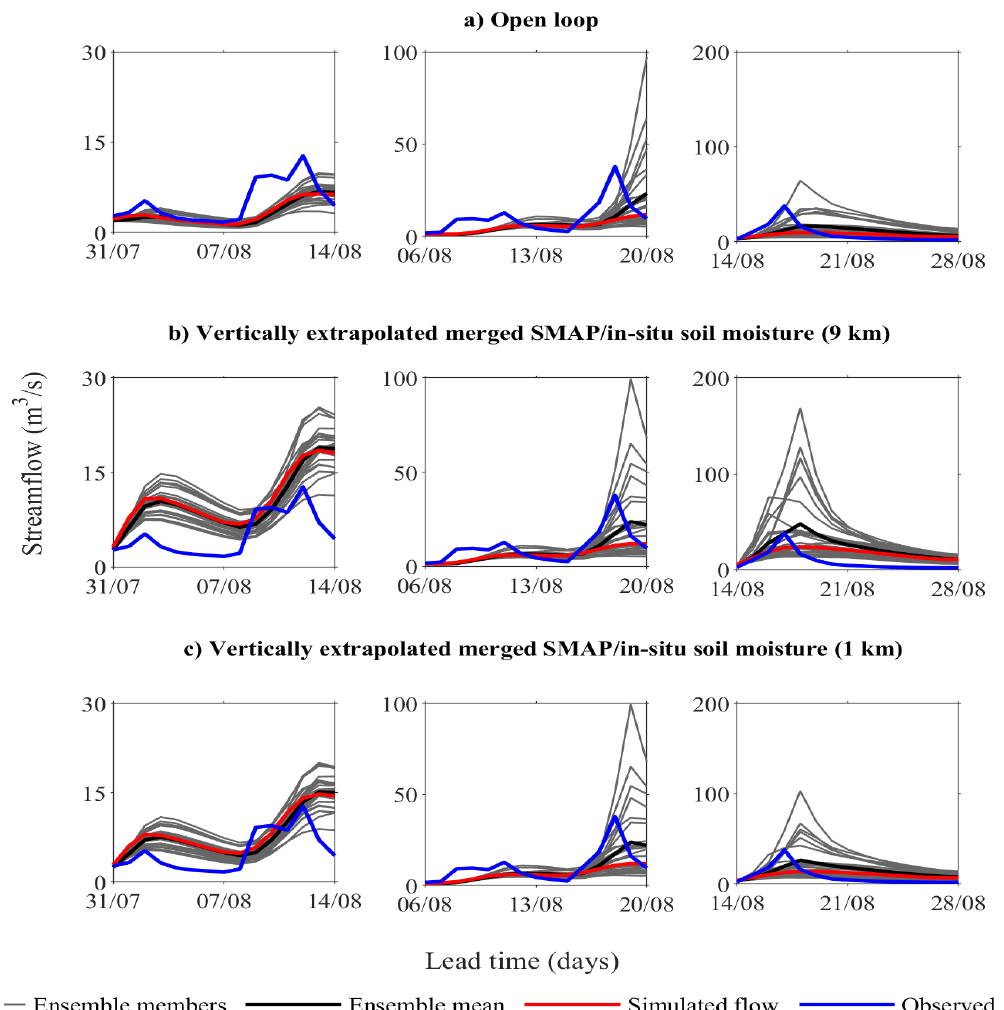
Figure 10. Ensemble streamflow forecast at the outlet of au Saumon watershed by the: ( a ) open loop; ( b ) the model updated with vertically extrapolated merged SMAP/in-situ (9 km); ( c ) vertically extrapolated merged SMAP/in-situ(1 km).